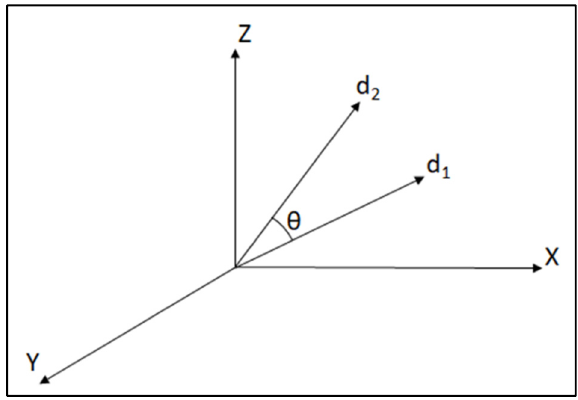
Figure 8. Cosine similarity algorithm. Algorithm 1. Generation of point cloud features.